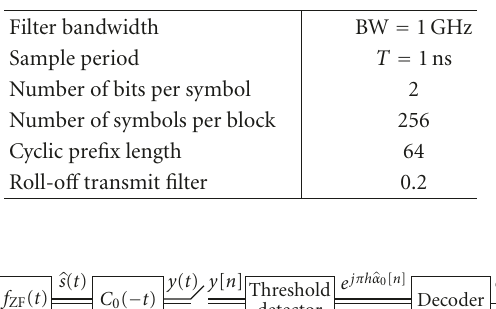
Table 5: System parameters OQPSK.